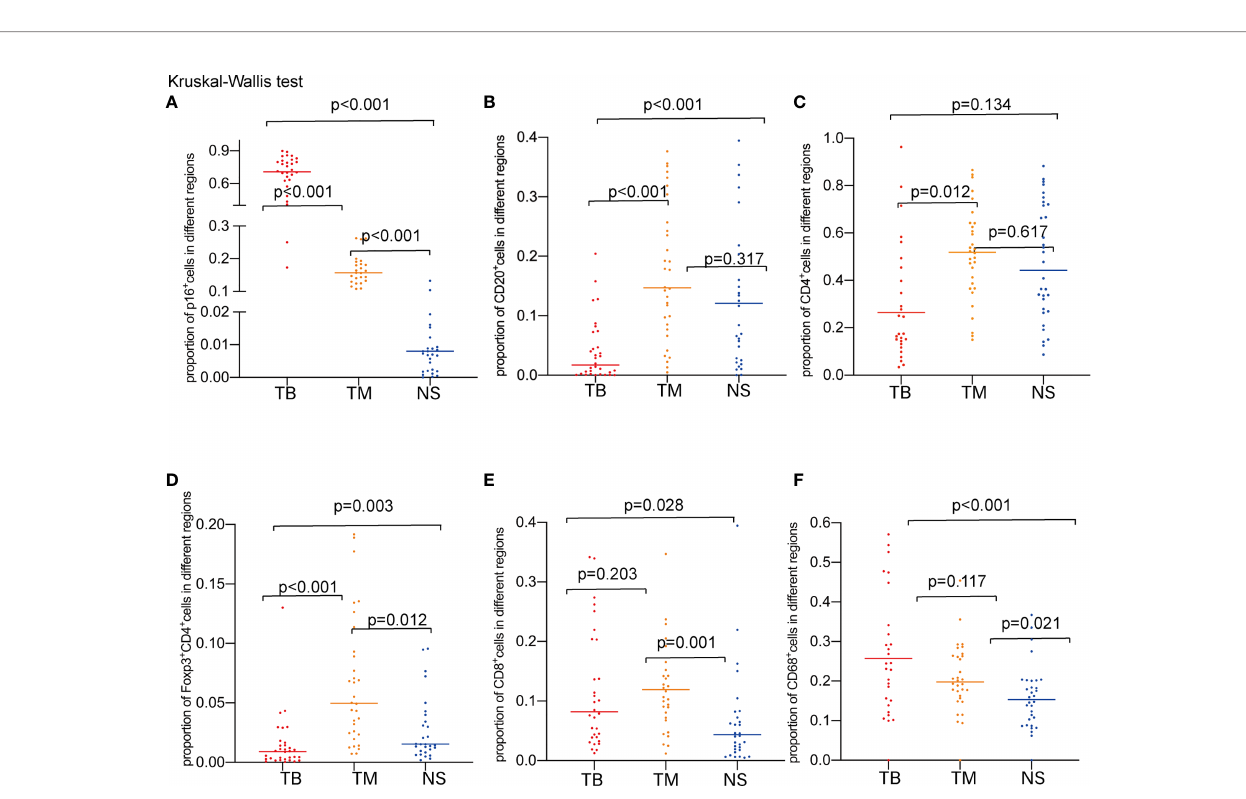
FIGURE 4 | Proportions of marker-positive cells according to TB, TM, and NS regions. (A) Comparison of the proportions of P16 + cells. (B) Comparison of the proportions of CD20 + cells. (C) Comparison of the proportions of CD4 + cells. (D) Comparison of the proportions Foxp3 + CD4 + cells. (E) Comparison of the proportions of CD8 + cells. (F) Comparison of the proportions of CD68 +